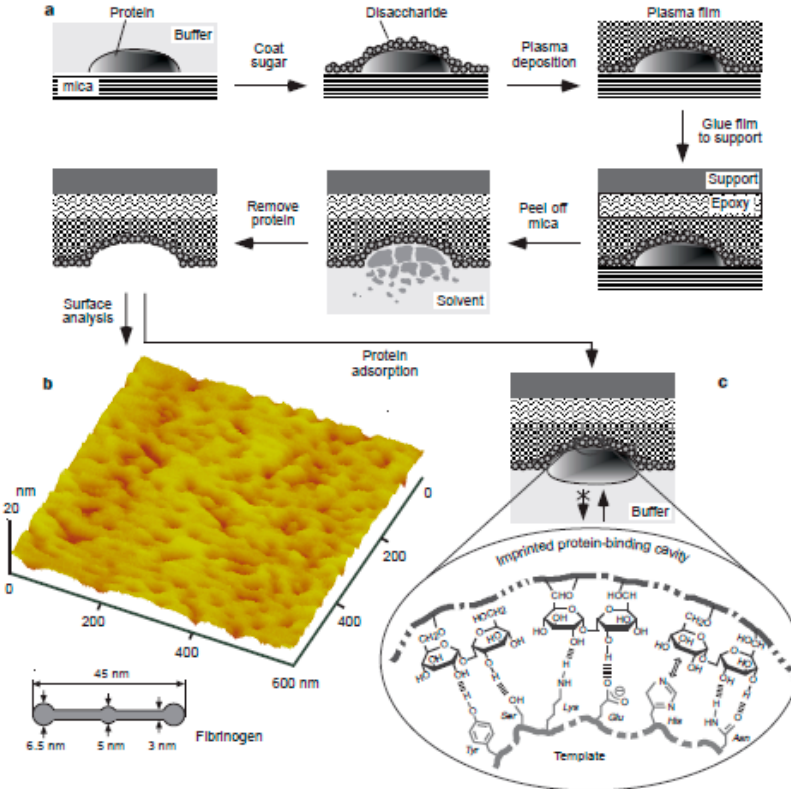
Figure 2. Protocol for template imprinting of proteins; ( a ) Template protein was adsorbed onto a mica and this surface was spin-coated with disaccharide to form a sugar overlayer. Plasma deposition was conducted to form a plasma film on top. The resulting plasma film was fixed to a glass cover slip. Then, mica was peeled-off and the protein was extracted. By this way, a nano-imprint with a shape complementary to the template protein was created on the imprint surface. ( b ) AFM image of the surface of a fibrinogen imprint, ( c ) Mechanism for the specific recognition of the imprinted surface. The main force for the selectivity was steric hindrance and an overall strong interactions which is due to many cooperative weak interactions including hydrogen bonds, Van der Waals forces and hydrophobic interactions (reproduced from [33] with permission).